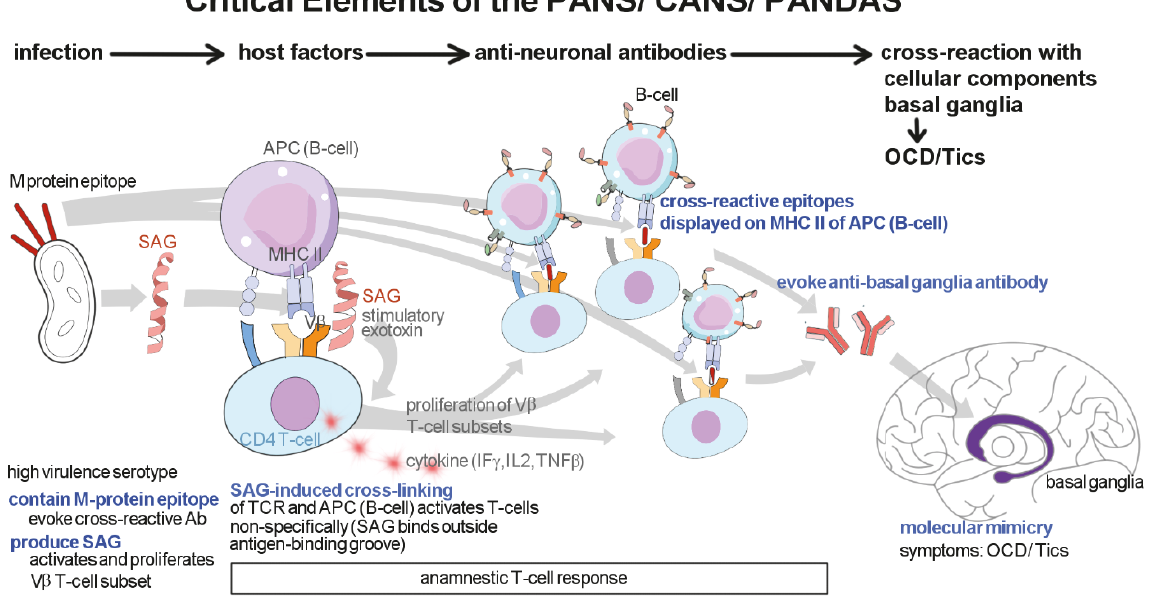
Figure 1: Hypothetical mechanism of postinfectious autoimmune neuropsychiatric syndromes. (1) Causative organism must contain M- protein epitopes that are capable of evoking antibody production that react with human neurons in the basal ganglia. They must also produce super-antigens(SAGs) thatactivateT-cellreleasing cytokines (Interferon 𝛾 , Interleukin2, and Tumor Necrosis Factor 𝛽 ) and proliferateT-cell (V subsets) resulting in anamnestic cell response. (2) T-cells bind to cross-reactive M-protein epitopes when displayed on surface MHC Class II molecules of B-cells. (3) B-cells are activated and (4) produce antibodies to M-proteins that cross-react with neuronal antigens in basal ganglia through the mechanism of molecular mimicry resulting in clinical manifestations such as OCD / tics [10].